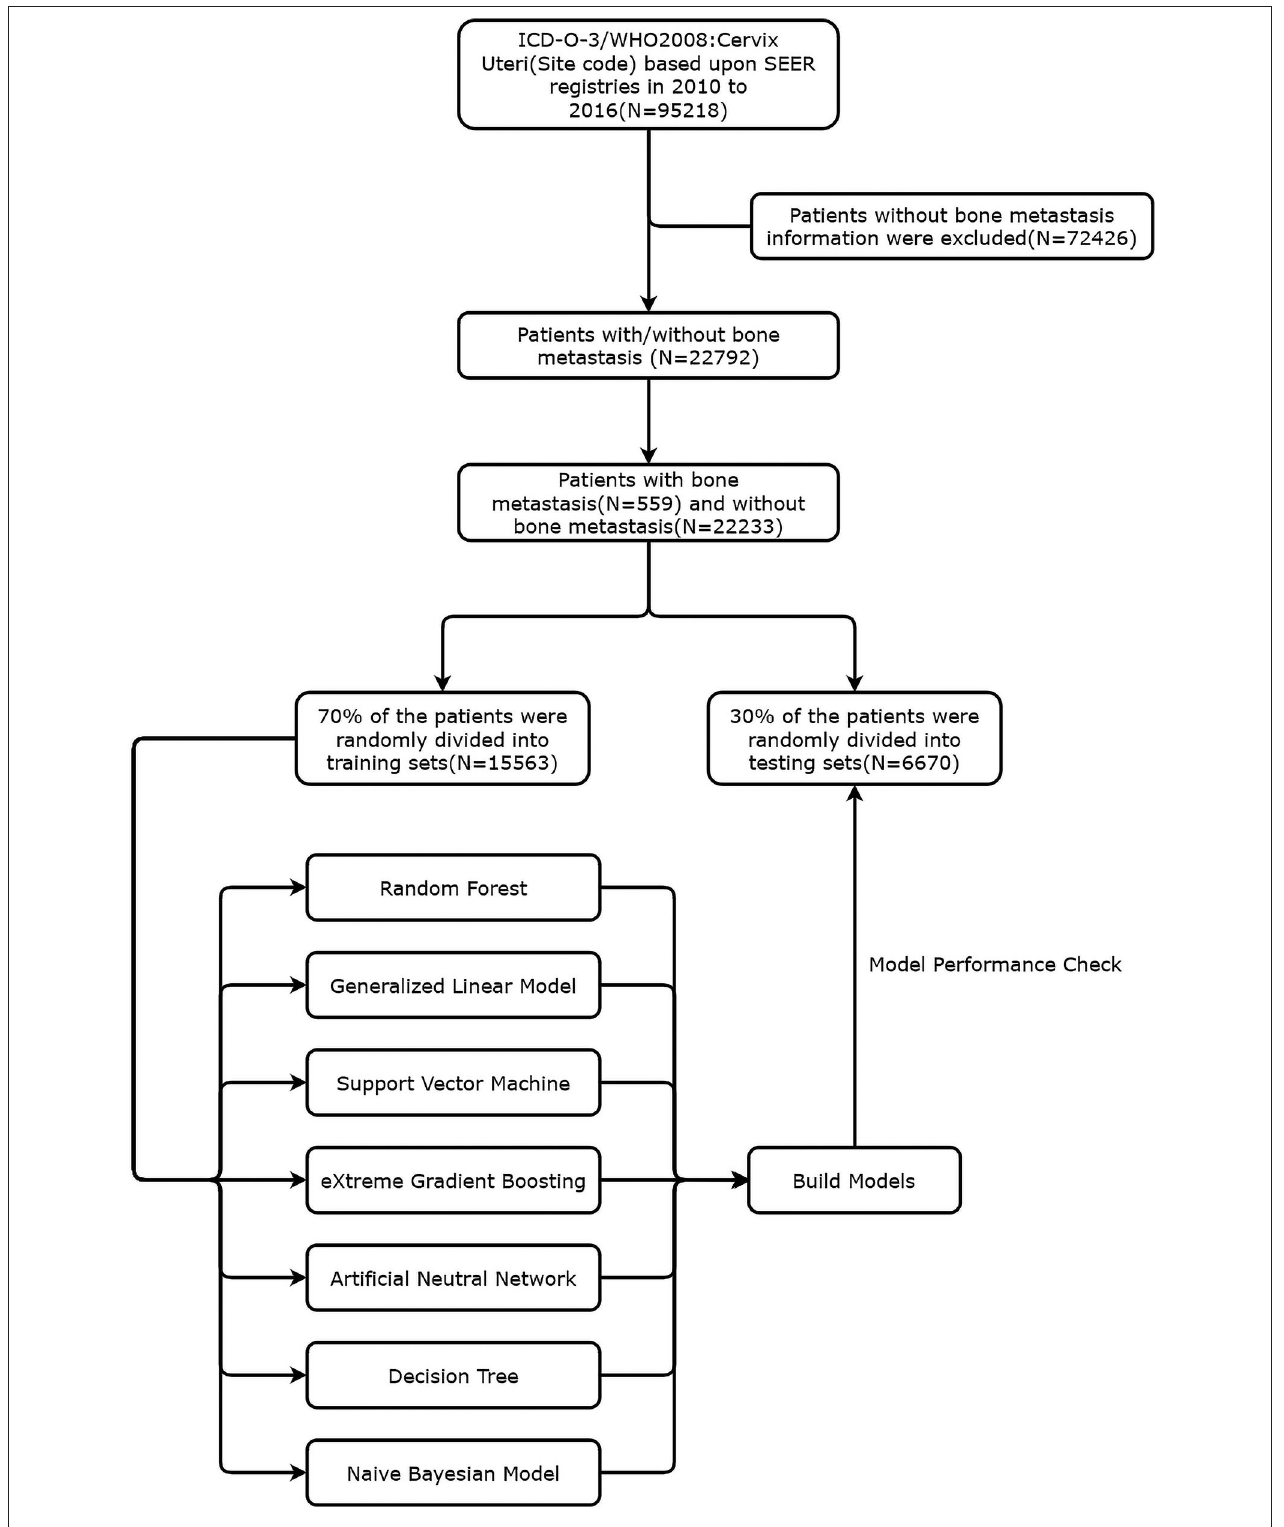
FIGURE 1 | Flow chart of cervical patients inclusion and model establishment.